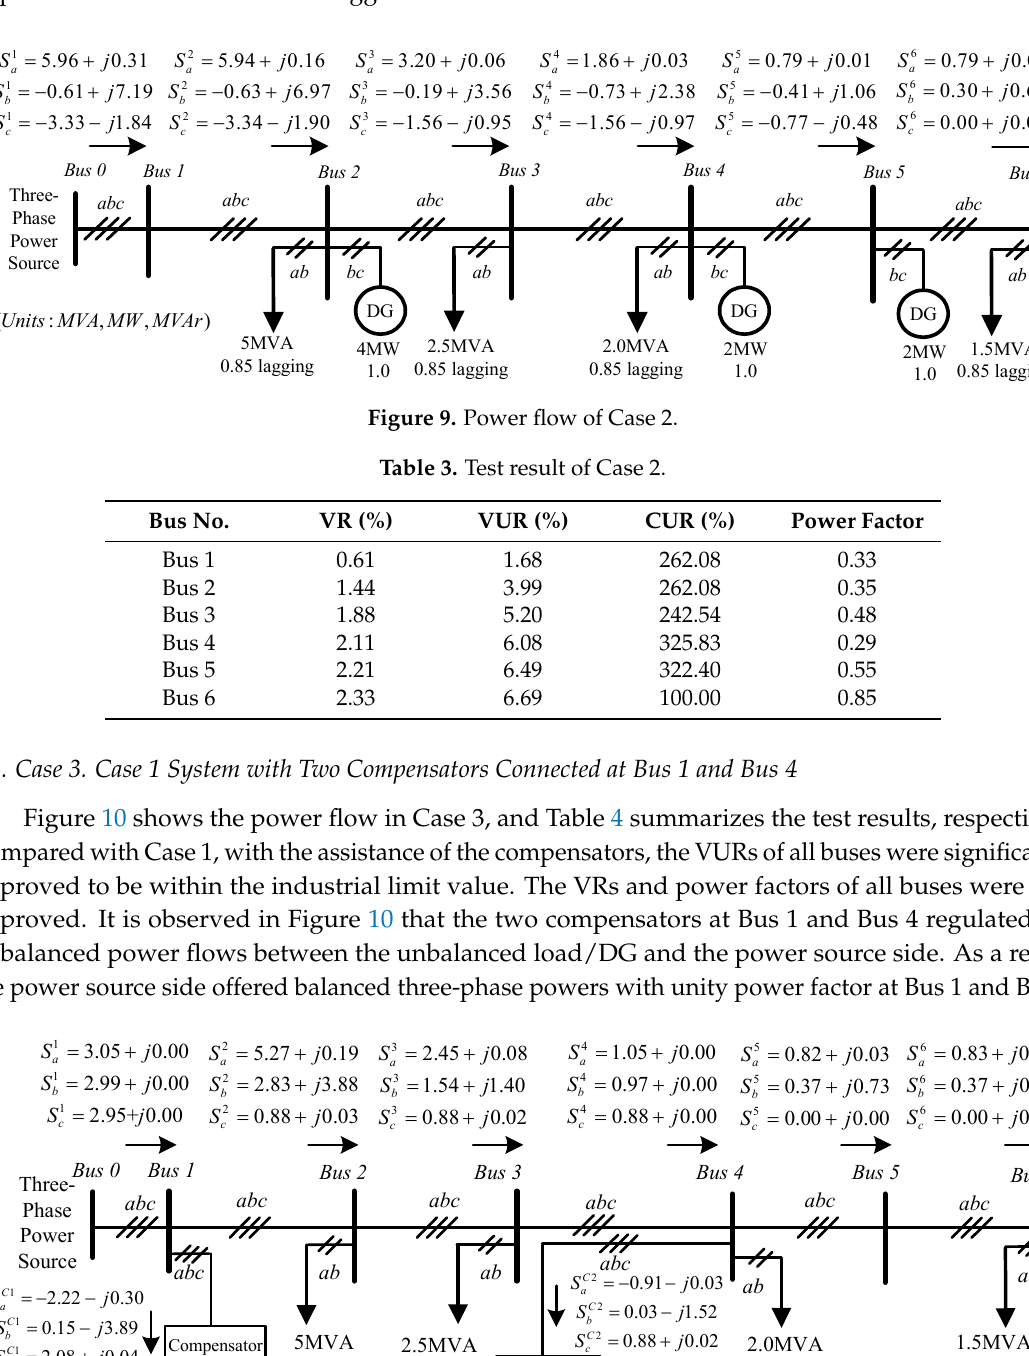
Figure 11. Power flow of Case 4. Table 5. Test result of Case 4. Bus No.